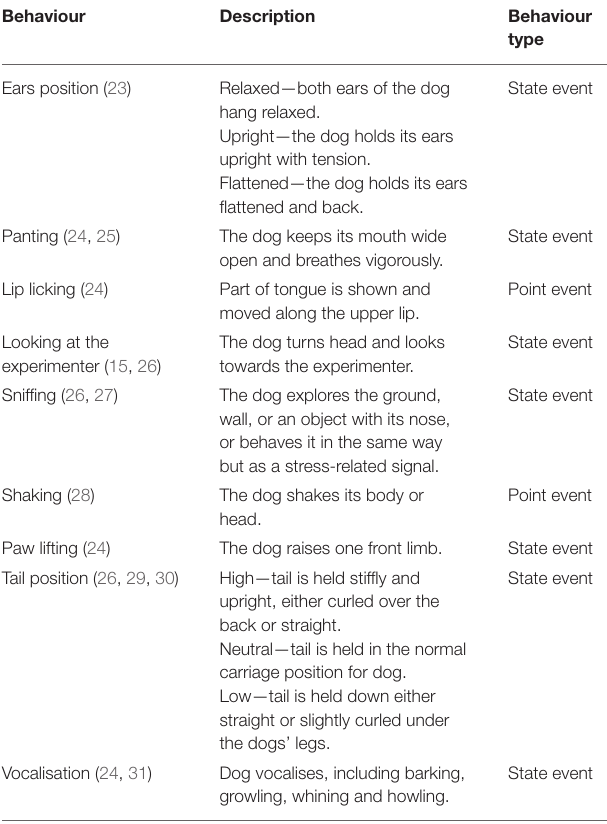
TABLE 1 | Ethogram of canine